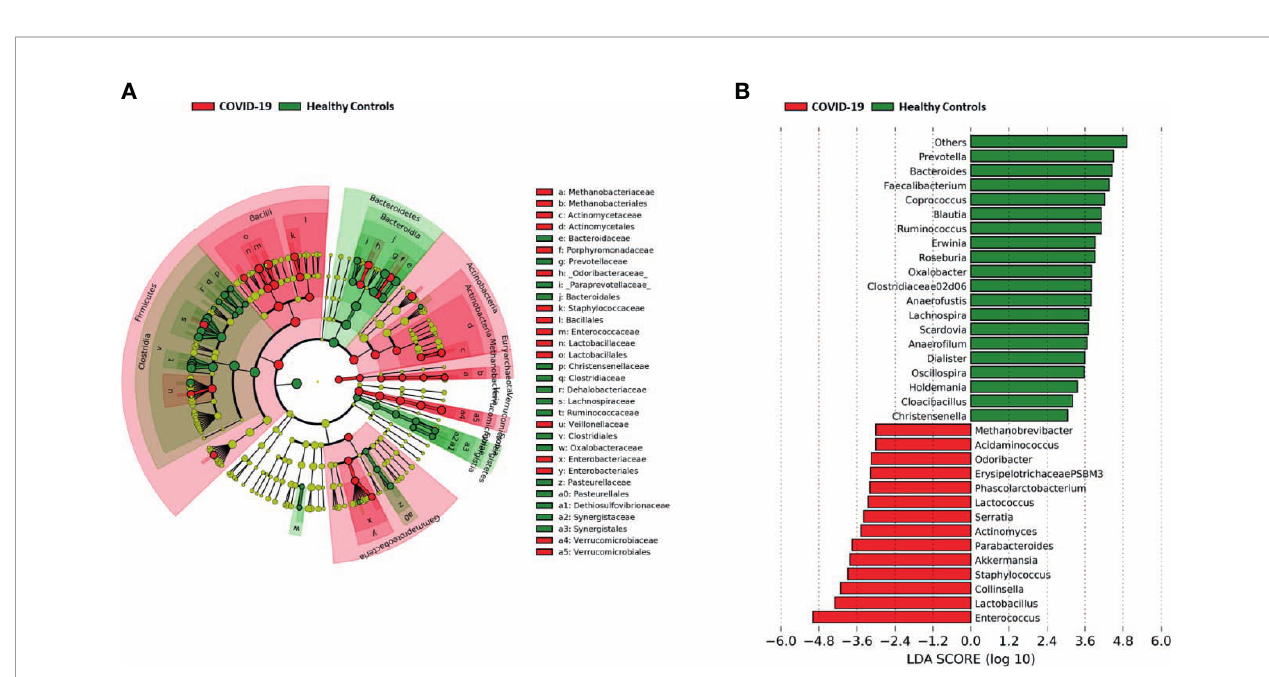
FIGURE 2 | Gut microbiota signatures of COVID-19. (A) Cladogram of microbial taxa differentially represented between COVID-19 patients and healthy subjects at phylum to family level. The diameter of each circle is proportional to the taxon abundance. (B) Linear discriminant analysis (LDA) scores of discriminating genera between groups (the logarithmic threshold for discriminative features was set to 3.0). Plots were obtained by LDA effect size (LEfSe)